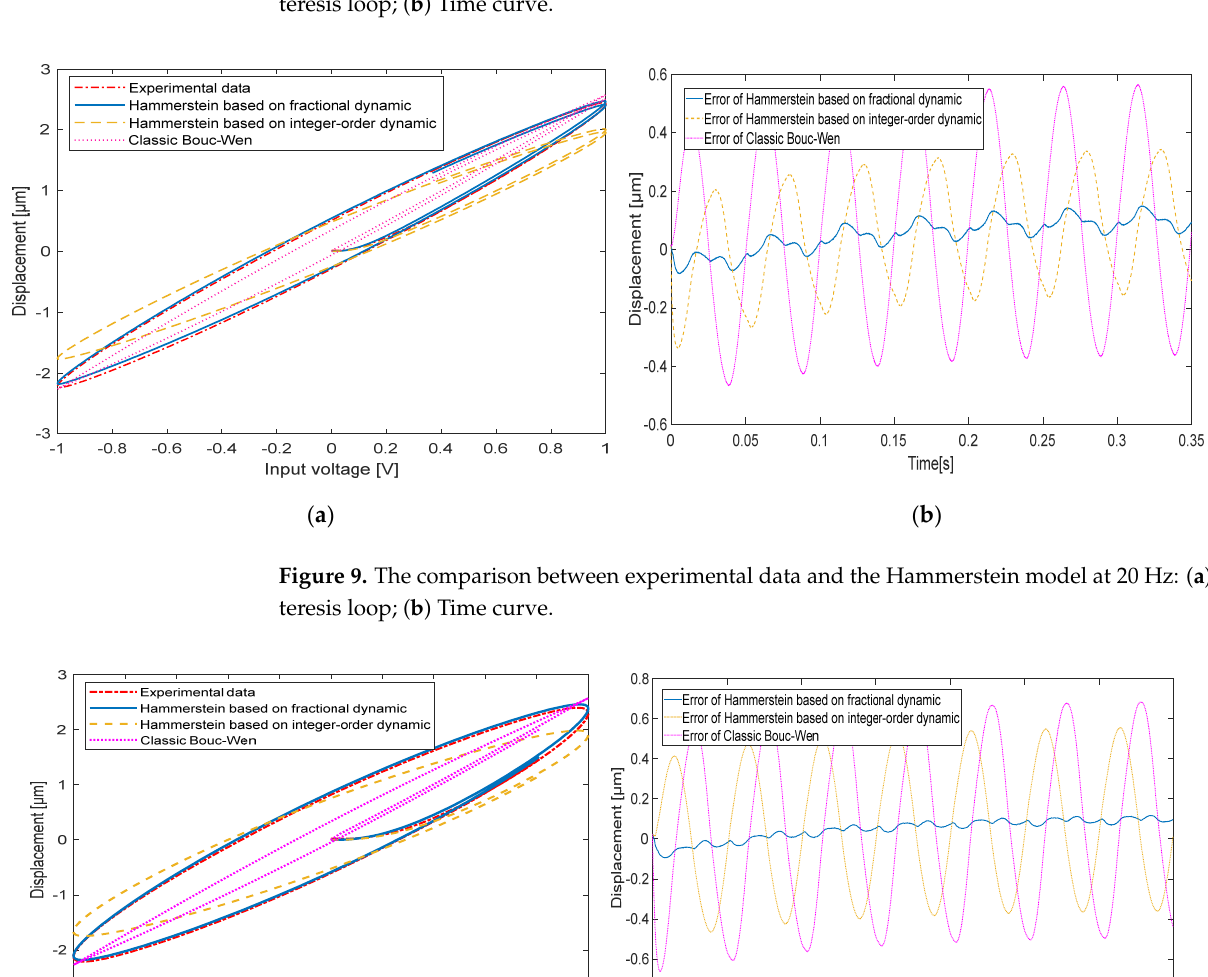
Figure 8. The comparison between experimental data and the Hammerstein model at 10 Hz: ( a ) Hysteresis loop; ( b ) Time curve.